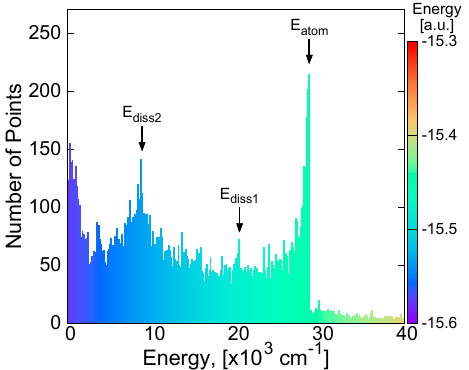
Figure 2. Population histogram of the calculation points over electronic energies. E atom , E diss 1 , and E diss 2 correspond to the atomization energy, dissociation energies in the Li 2 H → Li 2 + H and Li 2 H → Li + LiH, respectively (See text) .